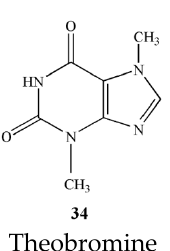
Figure 5. Chemical structures of alkaloids isolated from green tea.